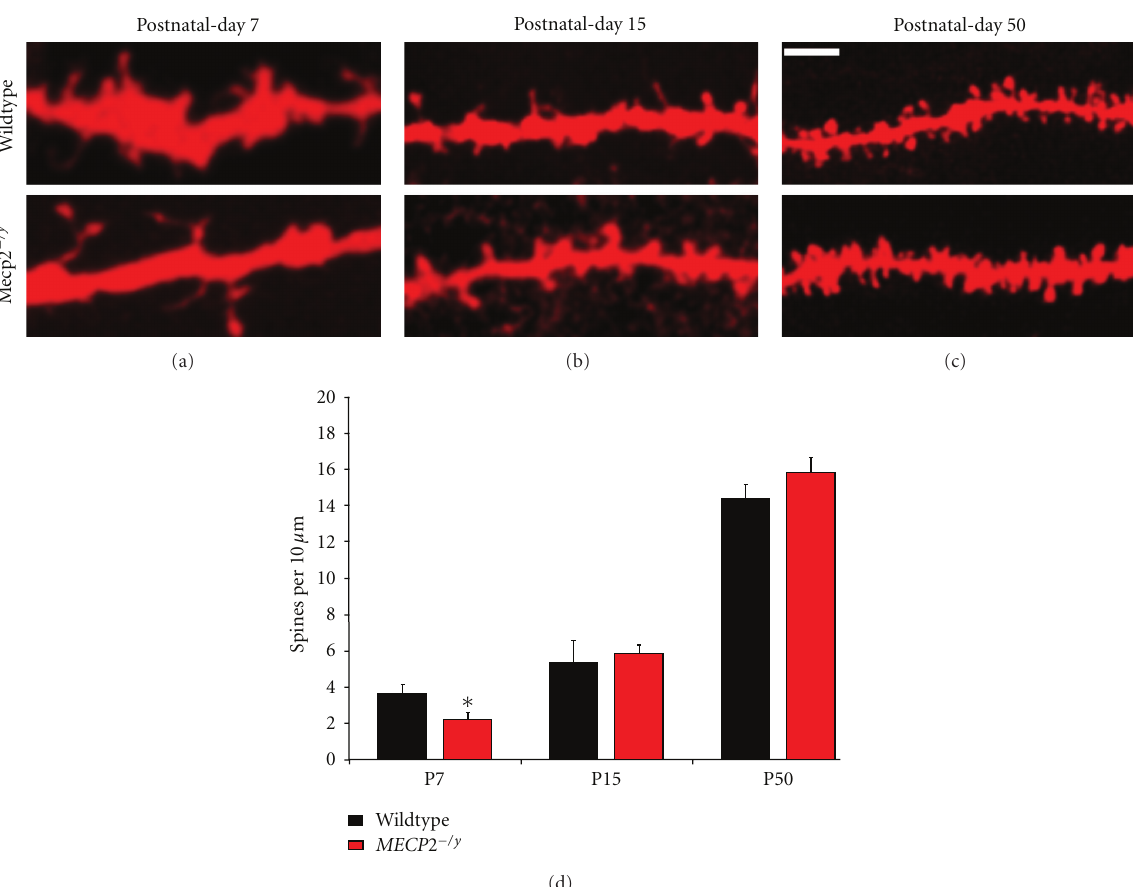
Figure 2: Quantitative analyses of dendritic spines in CA1 pyramidal neurons from Mecp2 mutant mice and age-matched wildtype littermates. (a) Representative examples of apical dendritic segments of CA1 pyramidal neurons from P7 wildtype and Mecp 2 tm 1 . 1Jae mice (top). Scale bar represents 2 µ m. ( b) Examples of apical dendritic segments of CA1 pyramidal neurons from P15 wildtype and Mecp 2 tm 1 . 1Jae mice (top). (c) Examples of apical dendritic segments of CA1 pyramidal neurons from P40 wildtype and Mecp 2 tm 1 . 1Jae mice (top). (d) Dendritic spine density (spines per 10 µ m of dendrite). All data are expressed as mean ± SEM. ∗ indicates P <